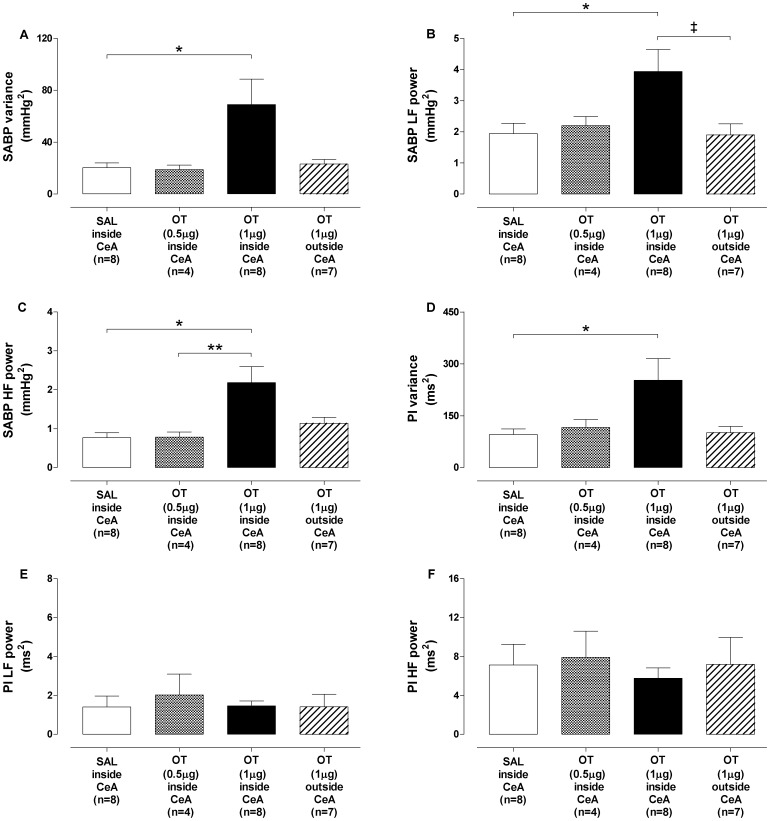
Systolic arterial blood pressure and pulse interval variability following oxytocin microinjection into central nucleus of amygdala.(A–C) Systolic arterial blood pressure (SABP) and (D–F) pulse interval (PI) variability analysis at 10 min after bilateral microinjections of oxytocin (OT) (black-white bar, n = 4), OT 1 µg (black bar, n = 8) or SAL (open bar, n = 8) into the central nucleus of amygdala (CeA) group and OT 1 µg outside CeA group (striped bar, n = 7). A and D: variance (σ2); B, C, E and F: power of the low and high frequency (LF; HF) bands. Data shown represent the means ± standard error of mean. (*) SAL inside CeA group vs OT 1 µg inside CeA group; (**) OT 0.5 µg inside CeA group vs OT 1 µg inside CeA group; (‡) OT 1 µg inside CeA group vs OT 1 µg outside CeA group.p<0.05, One-way ANOVA followed by Bonferroni's post hoc test.